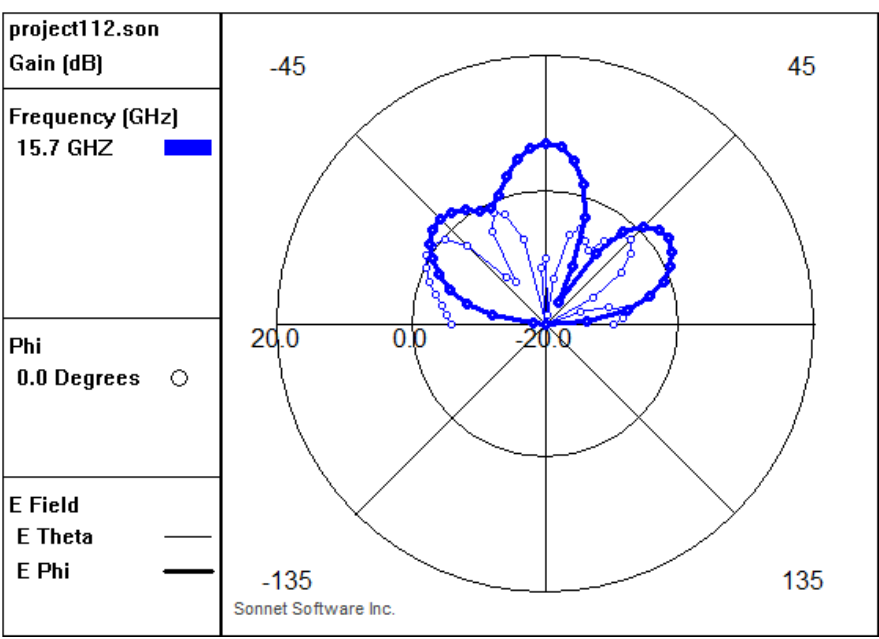
Figure 5. Radiation pattern of the antenna 15.7 GHz